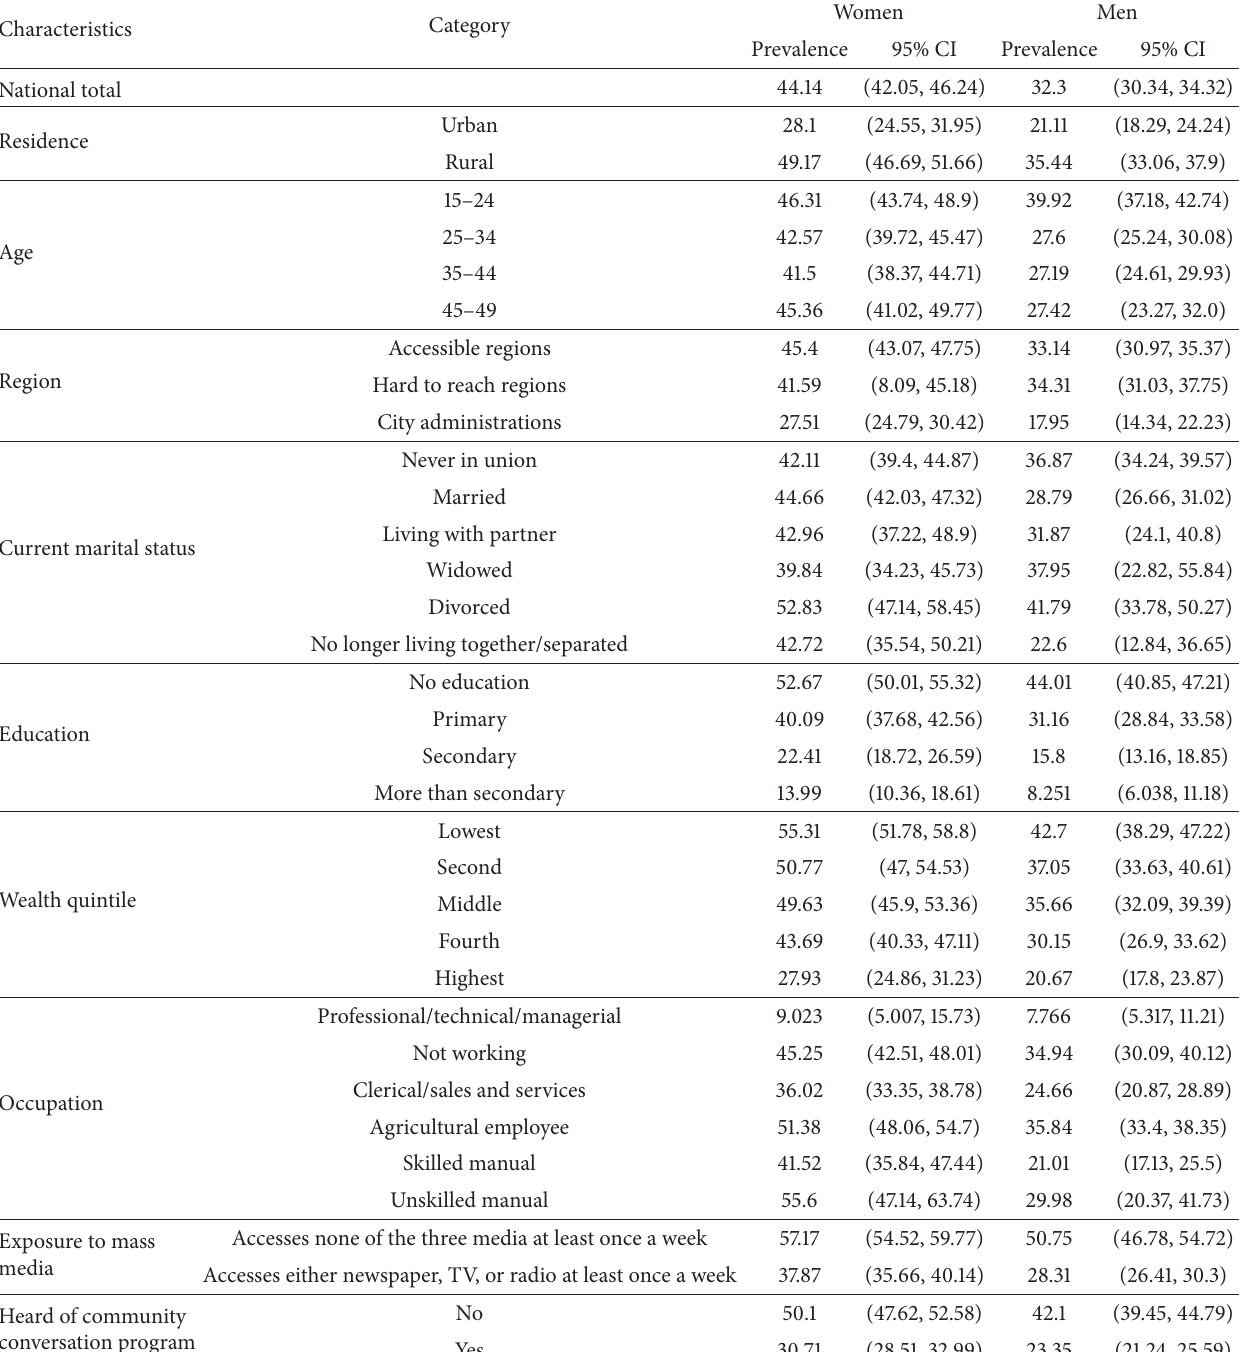
Table 3: Prevalence of low comprehensive TB Knowledge, Ethiopia